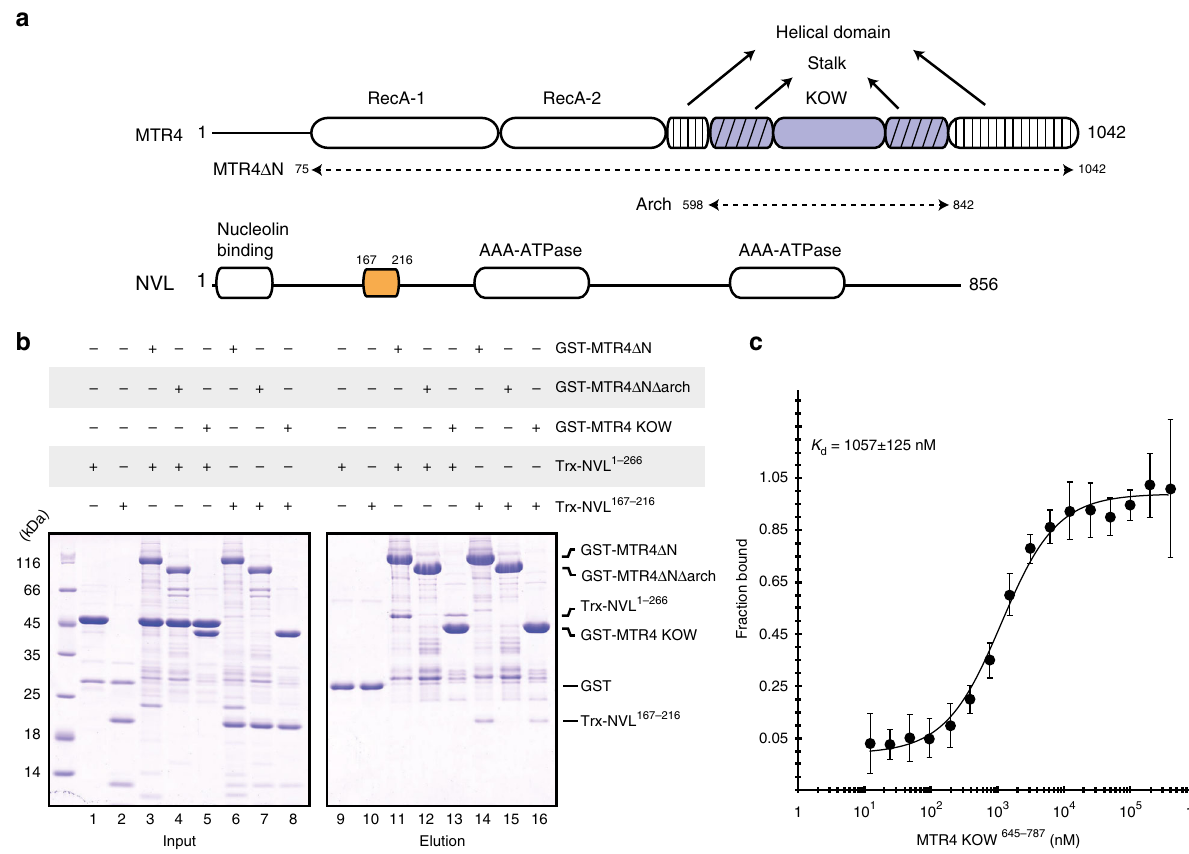
Fig. 1 The N-terminal unstructured region of NVL interacts with the MTR4 KOW. a Schematic representation of the domain organization of NVL and MTR4. Domain boundaries are obtained from previous studies 31,37 and the crystal structure in the current report. The arrows indicate nomenclature for MTR4 constructs used in the text. b Protein co-precipitation assays. GST-tagged MTR4 Δ N, MTR4 Δ N Δ arch, and MTR4 KOW were incubated with either Trx-NVL 1 – 266 or Trx-NVL 167 – 216 before co-precipitation with glutathione sepharose beads. A total of 3% of the input (lanes 1 – 8) and 30% of the eluates (lanes 9 – 16) were analyzed on 15% SDS-PAGE gels stained with coomassie brilliant blue. c Microscale thermophoresis experiment with MTR4 KOW and Trx-NVL 167 – 216 -(GS) 3 -eYFP. In all, 50 nM of Trx-NVL 167 – 216 -(GS) 3 -eYFP was incubated with increasing concentrations of MTR4 KOW and thermophoresis was measured by tracking the fl uorescence of the NVL-YFP fusion protein. The binding isotherm was calculated using MO software (Nanotemper technologies) and the dissociation constant ( K d ) is given in the inset. The error bars represent the standard deviations of each data point calculated